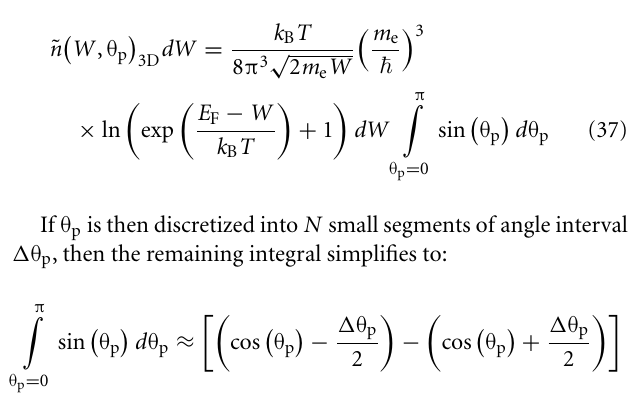
FIGURE 4 |Three-dimensional polar coordinate system for photonic illumination .